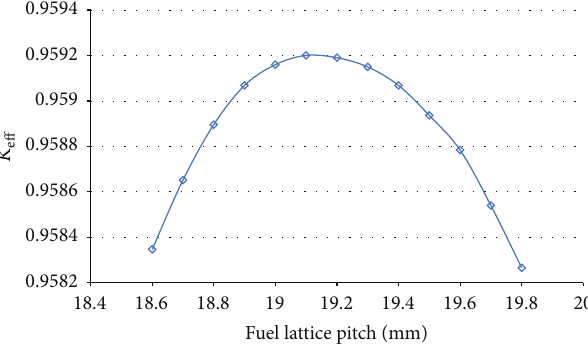
) versus fuel pitch. eff